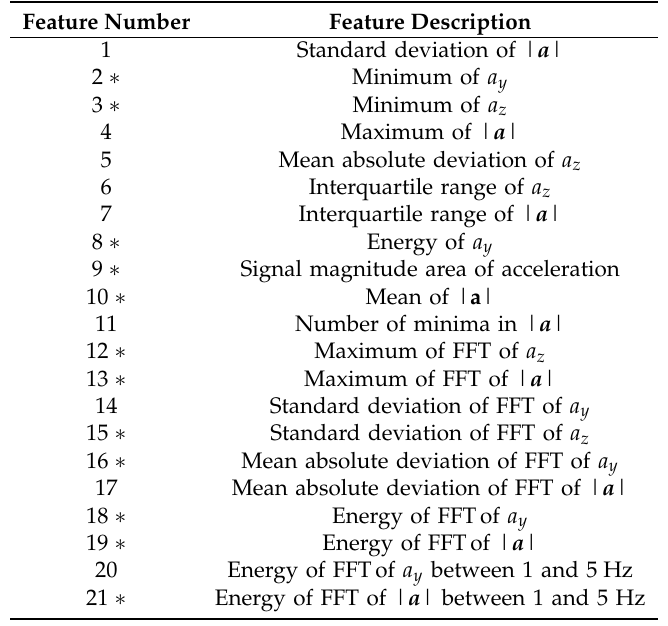
Table 2. Features in Ω f , C ∪ Ω f , MI for the RBF SVM algorithm, where Ω f , i is the final feature set for ranking approach i ∈ { C , MI } . Features marked with an * are features that are part of both feature sets.